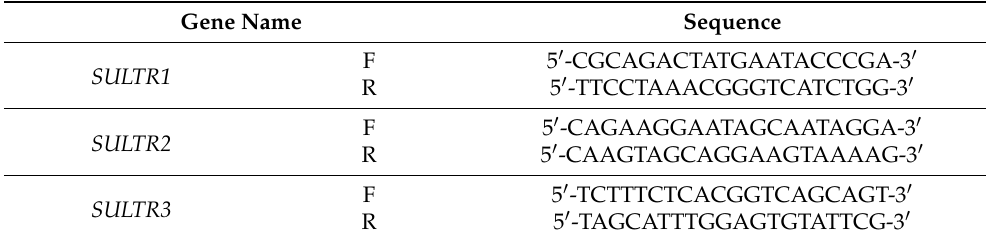
Table 1. Oligonucleotide primer pairs used for quantitative RT-PCR analysis. Gene